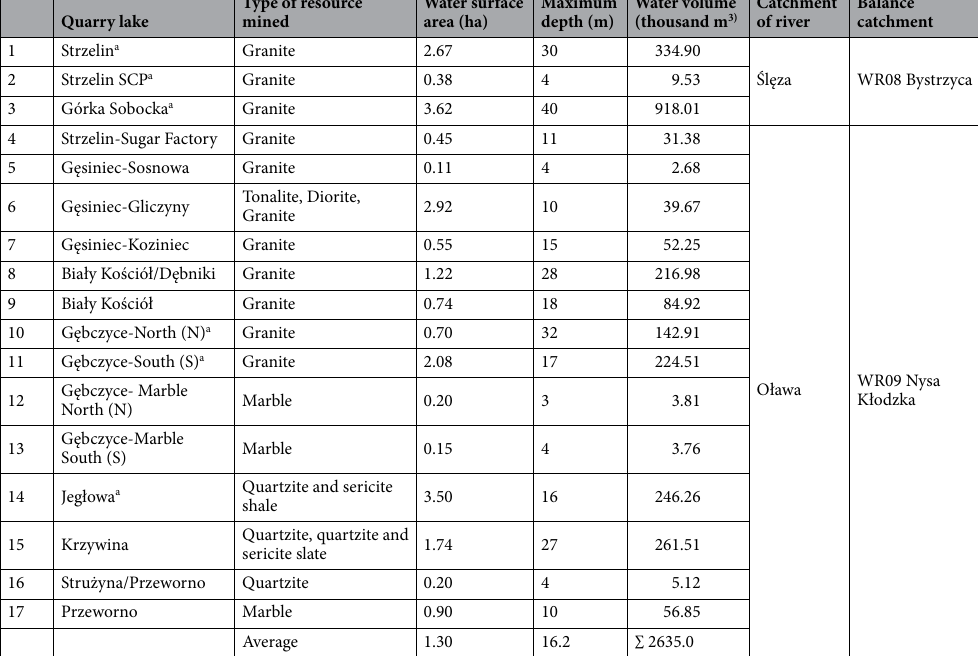
Table 2. Characteristics of Strzelin Quarry Lakes. a Situated in active